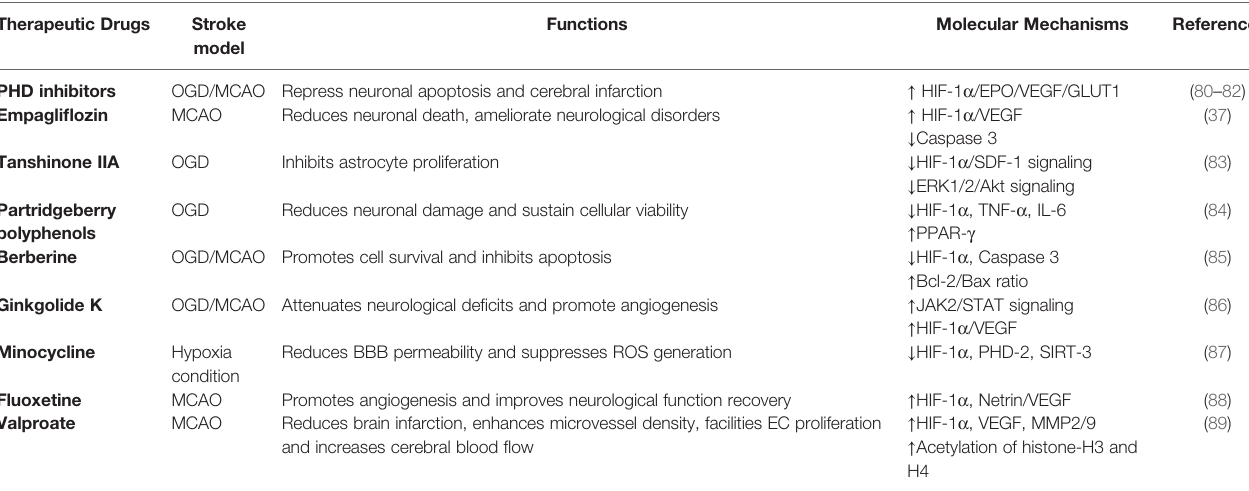
TABLE 2 | Therapeutic drugs that promote neuroprotection by regulating HIF-1 a . Therapeutic Drugs Stroke model